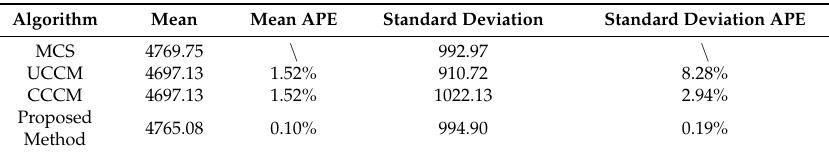
Table 4. Comparison of generation cost (modified IEEE 9-bus test system).